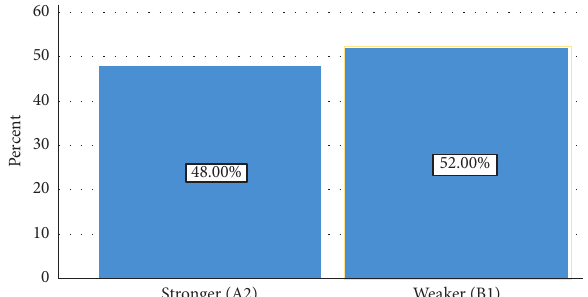
Figure 2: Relative strengths of semantic gravity in student papers.